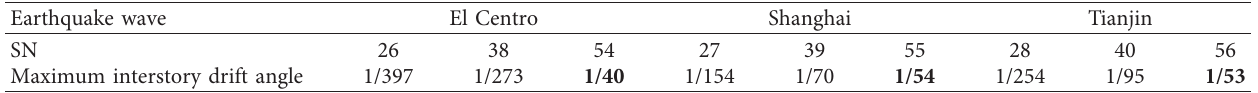
Figure 27: Envelope diagrams of the displacement response under the Tianjin earthquake. (a) Maximum layer displacement. (b) Interstory drift angle. Table 10: Maximum interstory drift